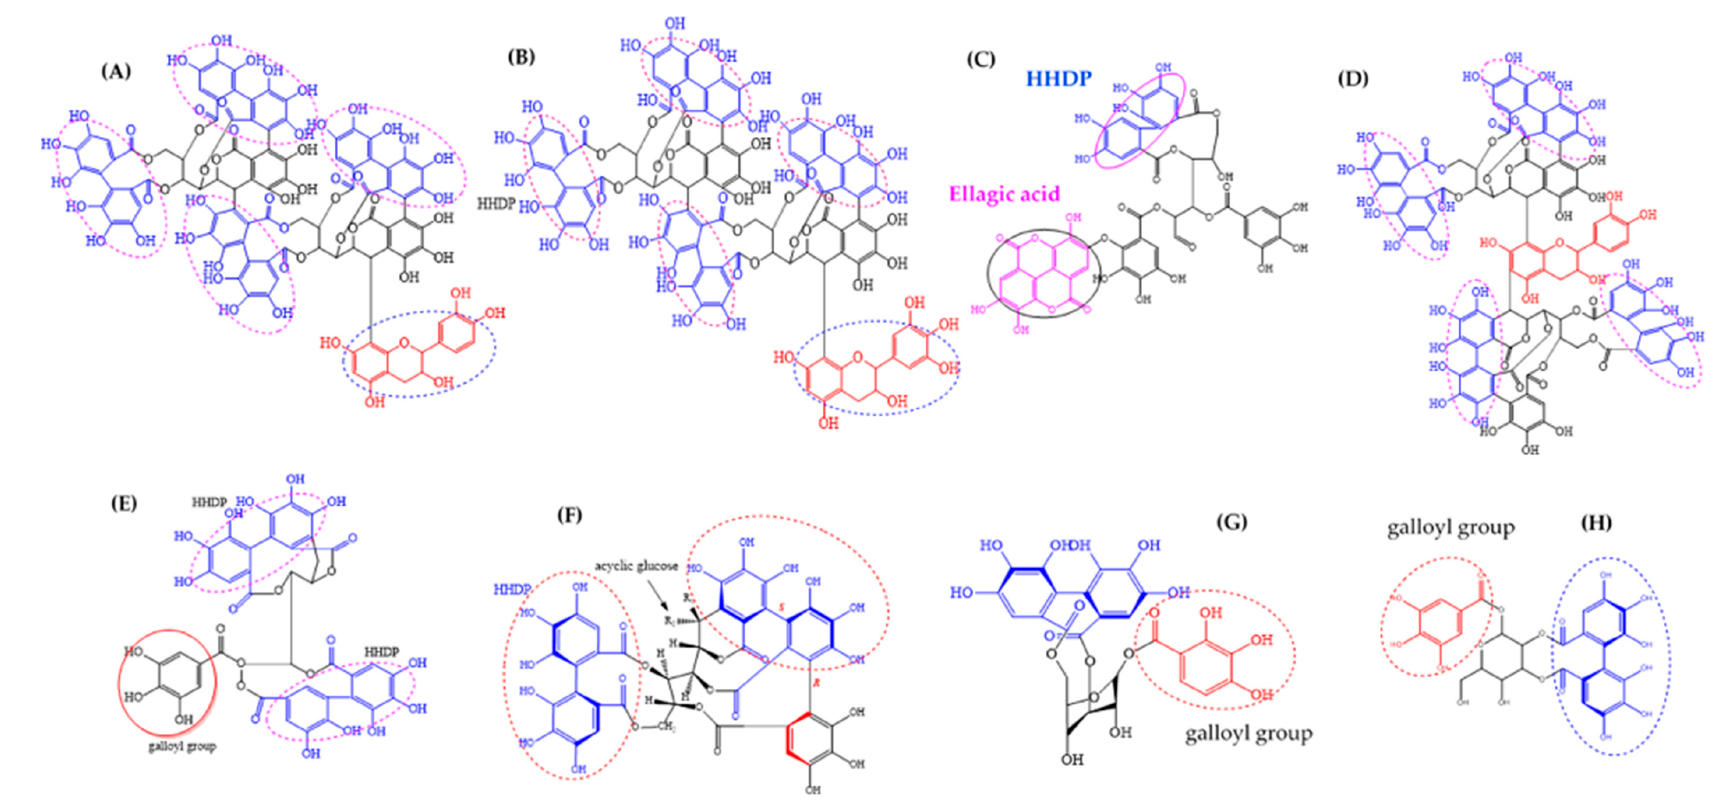
Figure 7. Chemical structure of ellagitannins identified from Anogeissus spp. and A. leiocarpa : ( A ) flavano-ellagitannin anogeissinin A, ( B ) anogeissinin B, ( C ) cornusiin B, ( D ) anogeissinin, ( E ) casuarinin, ( F ) castalagin (R1 = H; R2 = OH) and vescalagin (R1 = OH; R2 = H), ( G ) corilagin, and ( H ) isomer of corilagin sanguiin H4. DHHDP: dehydro-hexahydroxydiphenoyl; HHDP: hexahydroxydiphenoyl. Source for molecular structures: CAS, 2020.